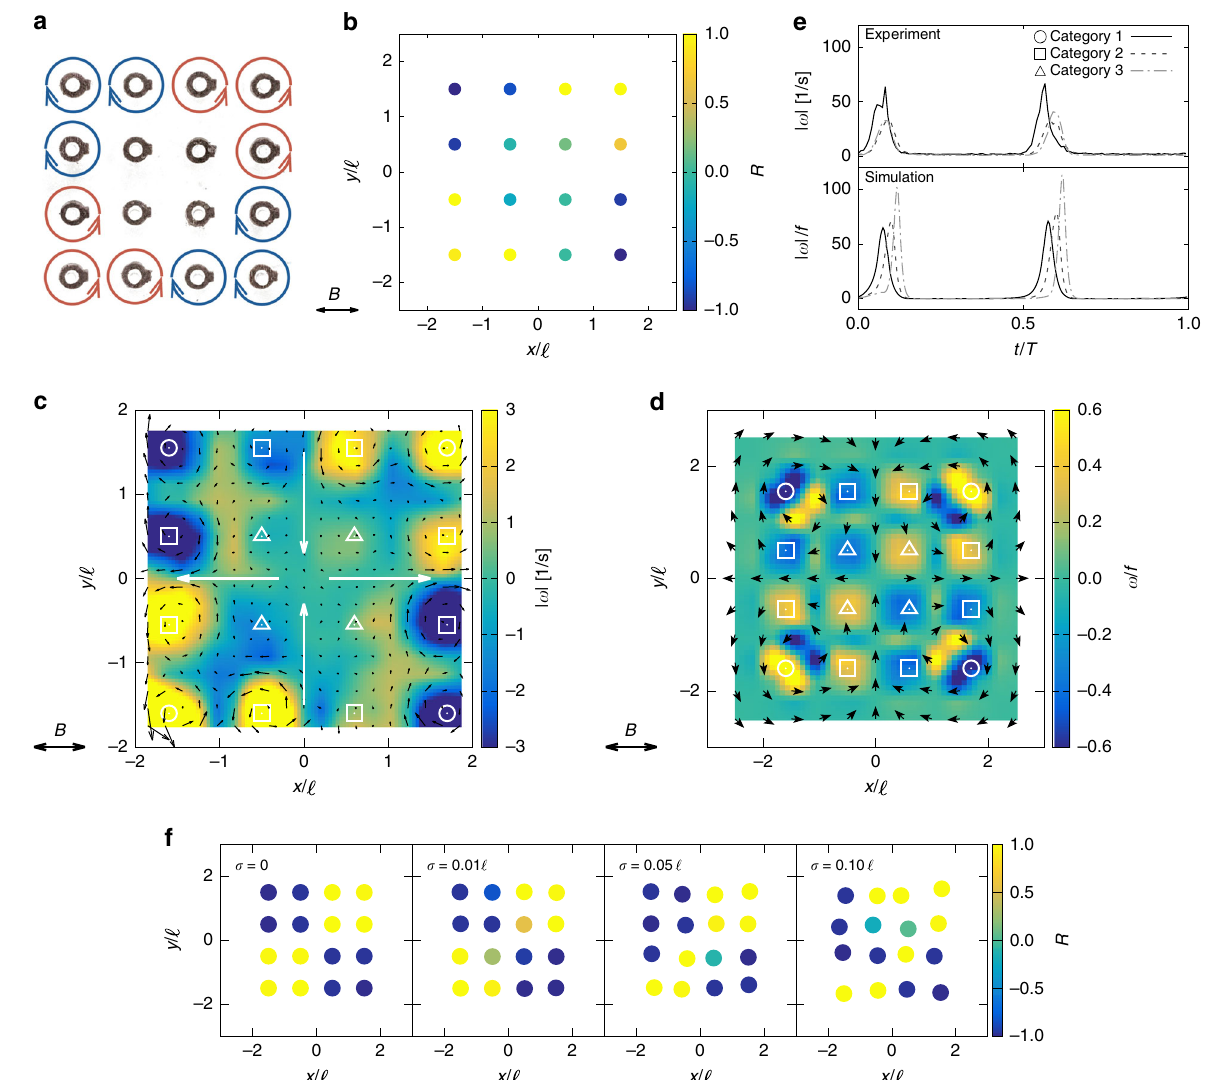
Fig. 3 The quarter rotational pattern. a Schematic showing the rotational pattern under alternating magnetic fi eld with α ¼ 6 : 0 and β ¼ 0 : 3. b The rotational parameter R of each rotor for a 4 × 4 rotor array. The dots depicts a single rotor, with blue meaning clockwise ( R ¼ (cid:2) 1) and yellow meaning counter-clockwise rotation ( R ¼ 1). The observation is based on 25 cycles. c , d Time-averaged fl ow fi eld generated by the rotors in c experiment ( α ¼ 6 : 0 and β ¼ 0 : 3) and d simulation ( α ¼ 6 : 0 and β ¼ 0 : 03). The contour shows the vorticity ω strength, the black arrows visualize the local fl ow fi eld and the large gray arrows show net fl ow fi eld created by the system. Symbols indicate the rotor position. e Time history of the vortex strength j ω j for three categories of rotors, in experiment and simulation. Note T ¼ 1 = f is the period. f Rotational pattern with a grid that has a Gaussian noise σ in the rotor position. The simulation is for α ¼ 50 : 0 and β ¼ 0 :